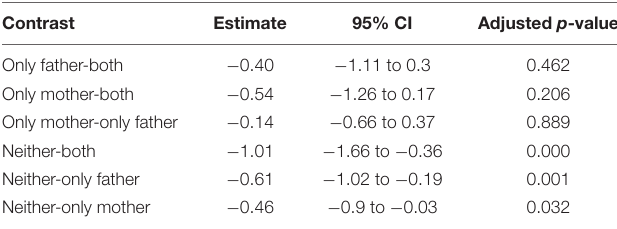
TABLE 1 | Summary of post hoc